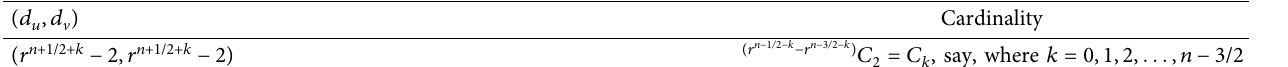
Table 11: Partition of pair of nodes ( u, v ) having distance 1.